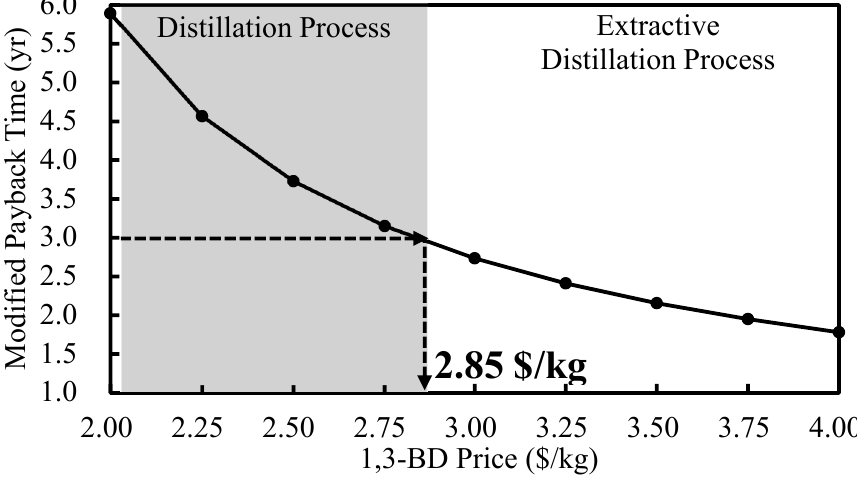
Figure 8. Process feasibility with changing 1,3-BD price.